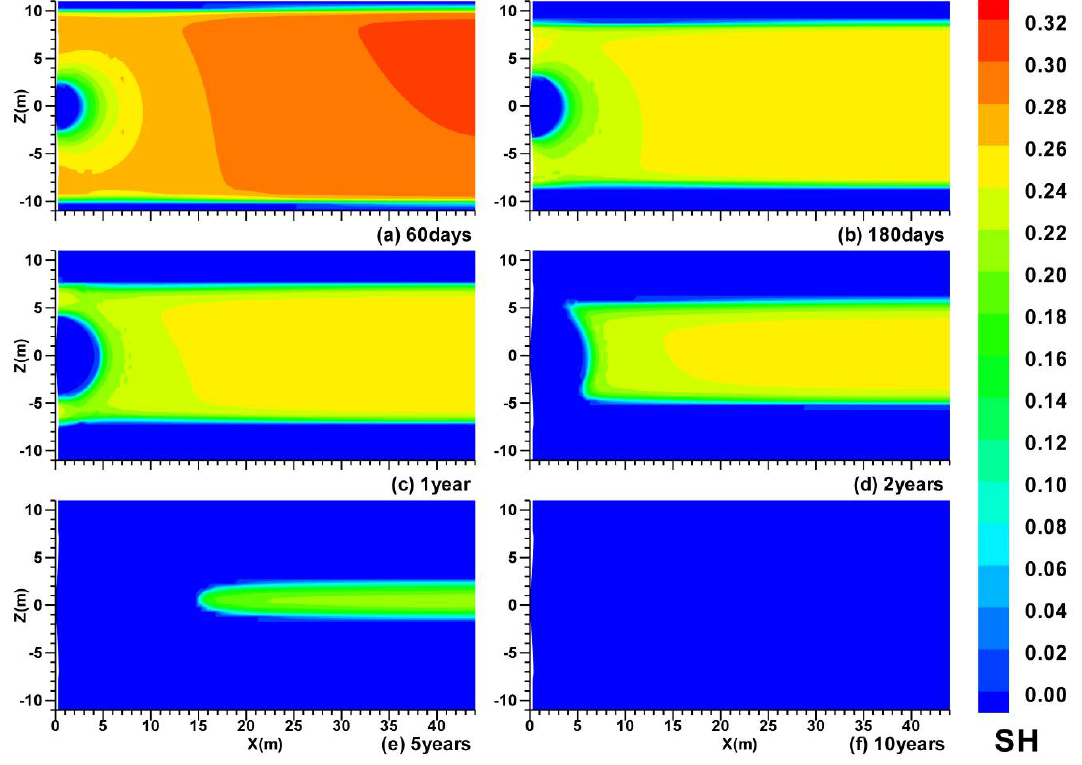
with impermeable boundaries (OB and H